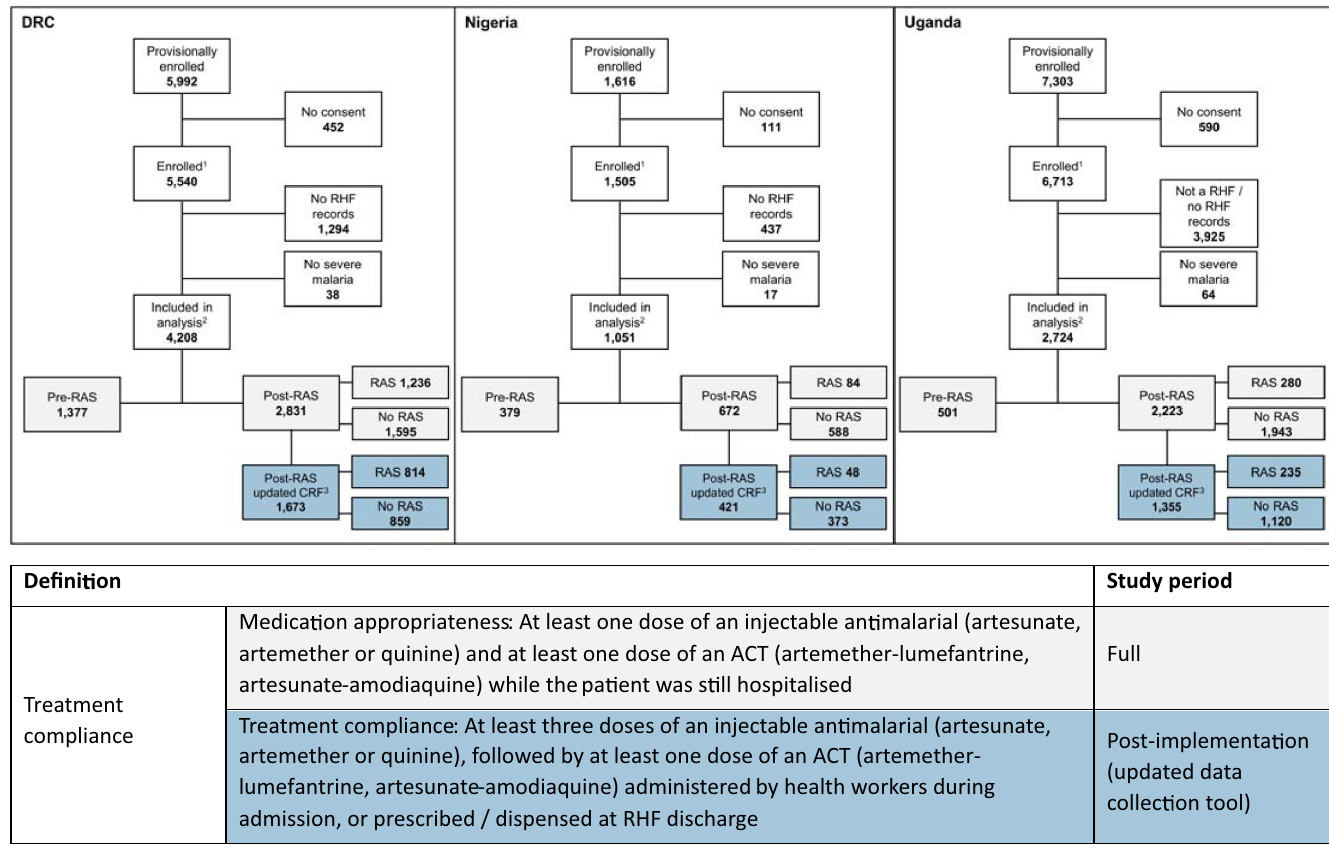
Fig 1. Details of analysis dataset and definitions of antimalarial treatment compliance. Of the 14,911 children enrolled in the CARAMAL study (either by a community-based provider or at the RHF), 7,983 underwent treatment at a RHF and were included in the analysis (2,257 enrolled during the RAS pre-implementation period (pre-RAS), 5,726 enrolled after RAS was rolled out (post-RAS)). A total of 1,600 received pre-referral RAS during the post-RAS phase, 4,126 did not. Medication appropriateness was assessed for the full dataset (highlighted in light grey), treatment compliance was analysed for the post-implementation subsample (shown with blue background). ACT, artemisinin-based combination therapy; CRF, case report form; DRC, Democratic Republic of the Congo; RAS, rectal artesunate; RHF, referral health facility. 1 Enrolled in CARAMAL study by community-based provider or directly enrolled at RHF. 2 Followed up after admission to RHF. 3 Post-RAS subsample with more detailed treatment